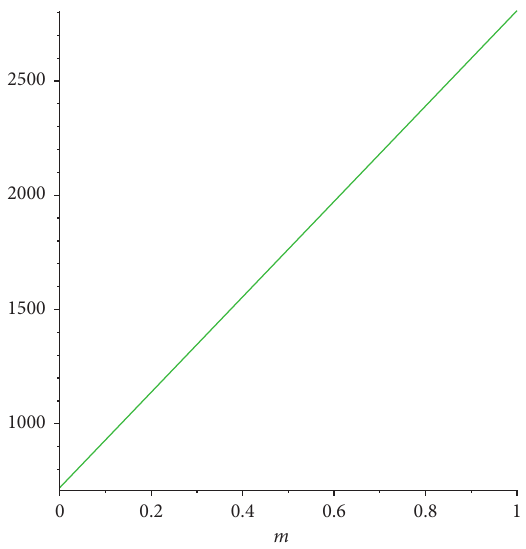
Figure 25: Plots of the second Gourava index for m − Bil